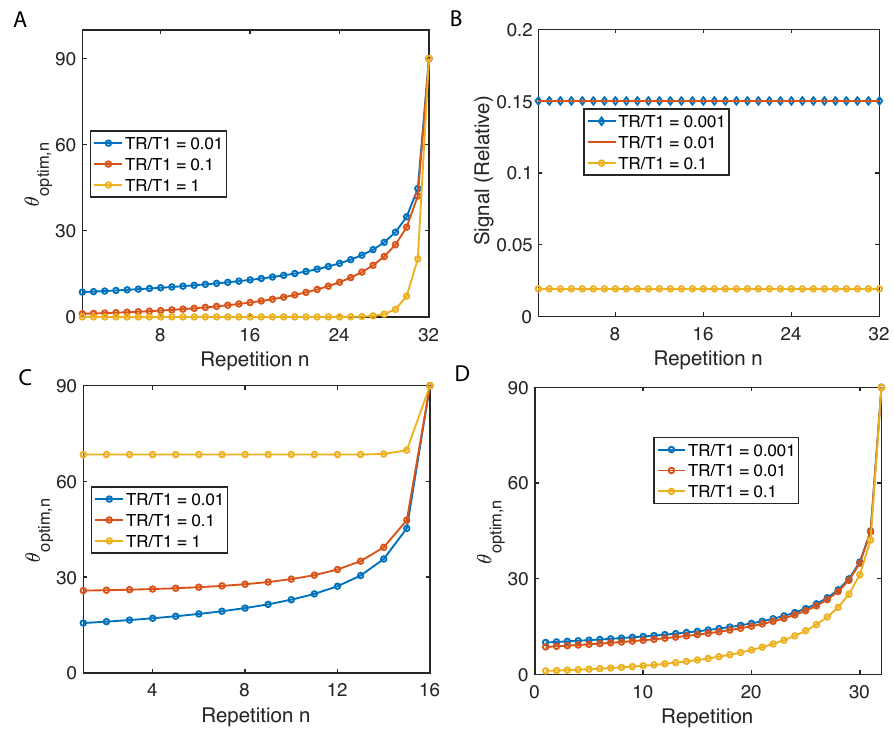
Figure 2. Variable flip angles for constant signal and maximum signal. ( A ) The flip angles to enable constant magnetization in a 32 repetition imaging sequence are determined based on Equation